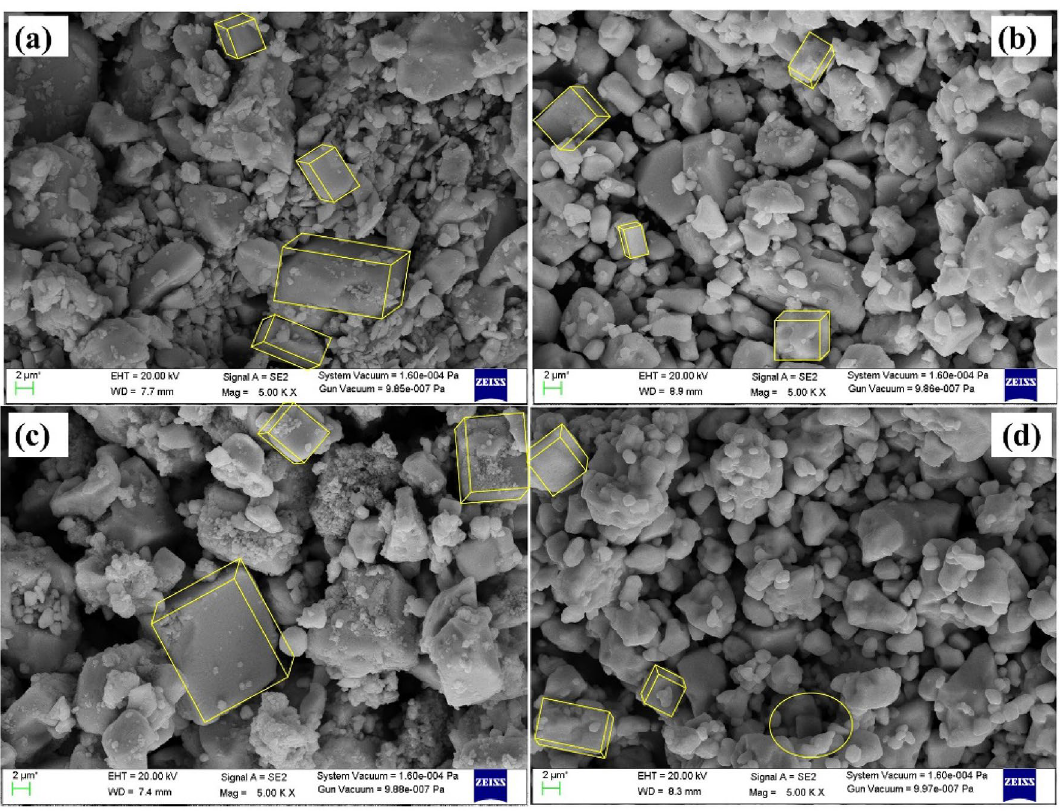
Figure 5. Micrograph of CsPbCl 3 and Co doped CsPbCl 3